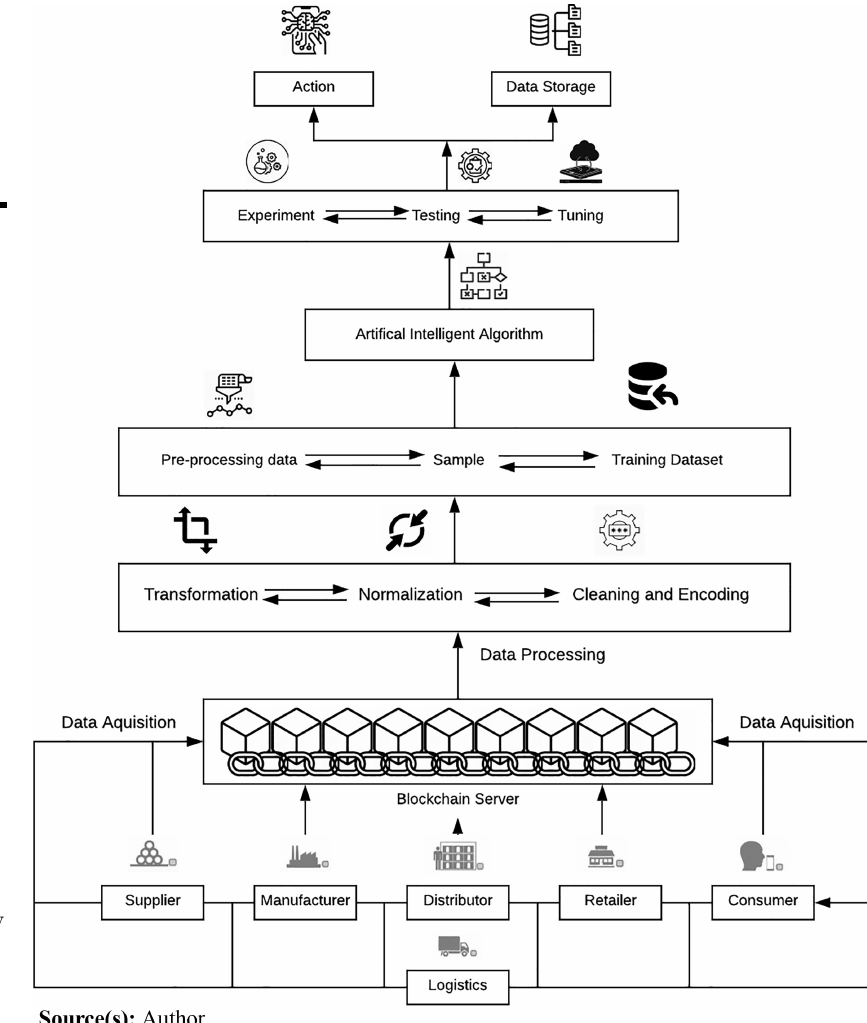
Figure 4. Blockchain